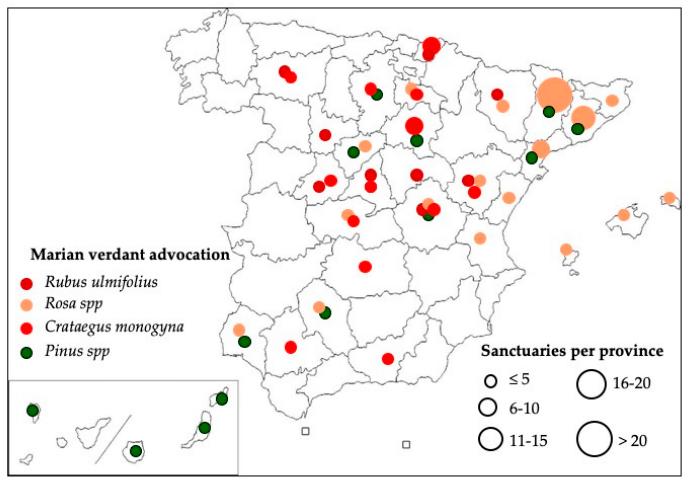
Figure 3. Geographical distribution of Rubus ulmifolius , Rosa spp., Crataegus monogyna , Pinus spp.